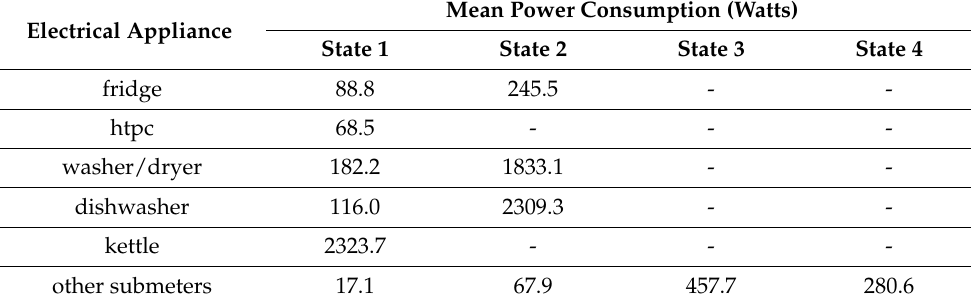
Relevant electrical appliances targeted for energy decomposition in this experi- ment/research.